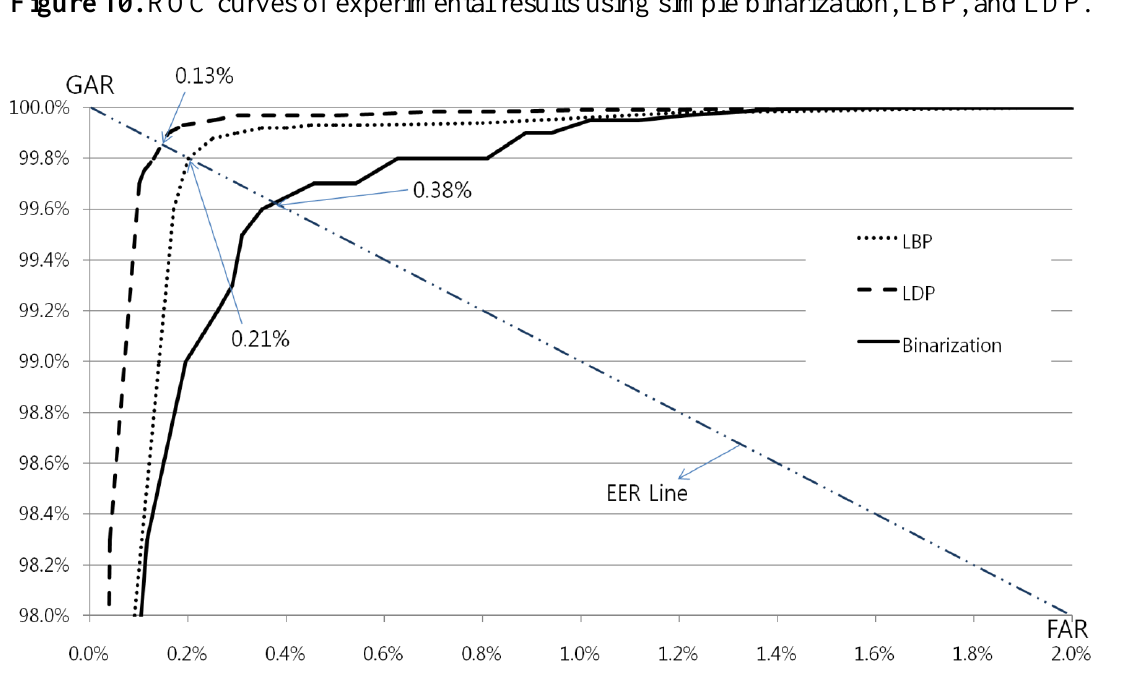
Figure 10. ROC curves of experimental results using simple binarization, LBP, and